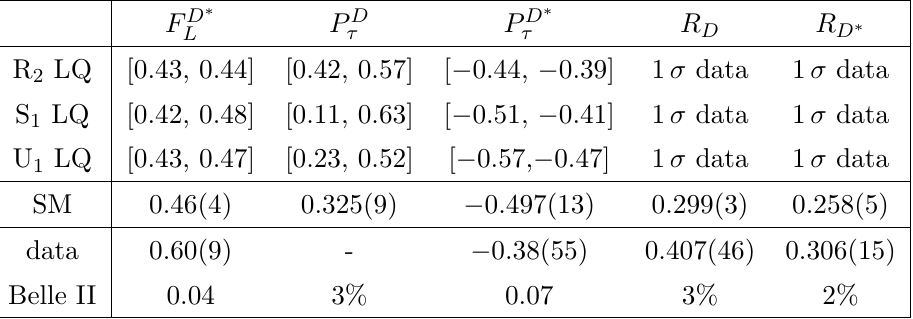
Table 1. Predicted ranges of the polarizations for R 2 , S 1 and U 1 LQ models ( (cid:22) LQ = 1 : 5 TeV), which satisfy the current 1 (cid:27) data of R and the bound of B ( B + ! (cid:28) + (cid:23) ) < 0 : 3. The SM predictions, D ( (cid:3) ) c the current data, and the expected sensitivity at Belle II with 50 ab (cid:0) 1 data [61, 67, 104] are also shown. The sensitivities for F D (cid:3) and P D (cid:3) are absolute uncertainty while the others are (cid:28) L